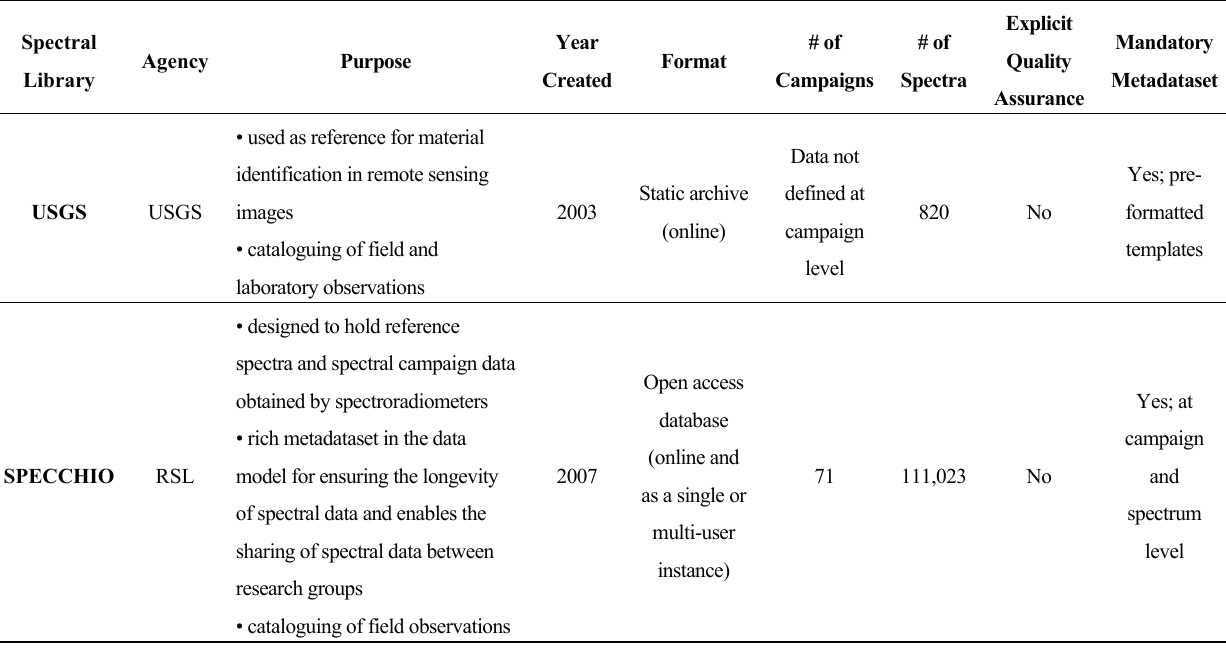
Table 1. Overview of USGS and SPECCHIO spectral data